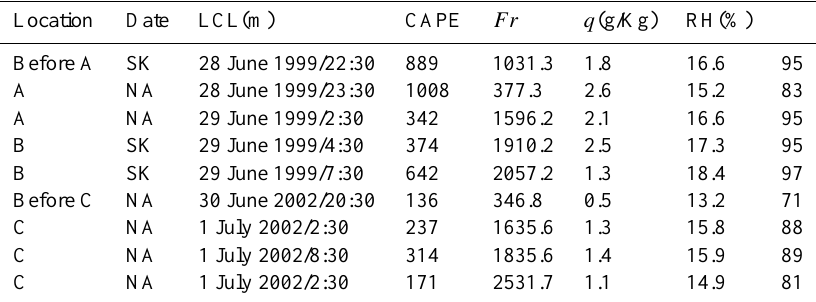
Table 3. Atmospheric parameters for each observation location.